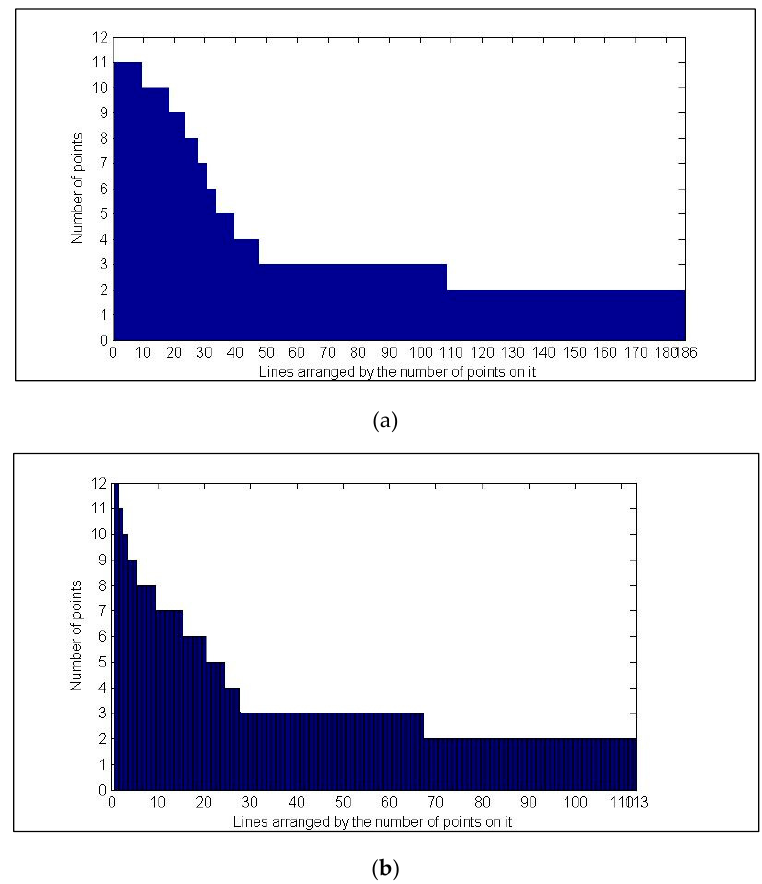
Figure 9. Histogram of the numbers of points of all lines. ( a ) TUM fr1_xyz; ( b ) TUM fr2_desk.